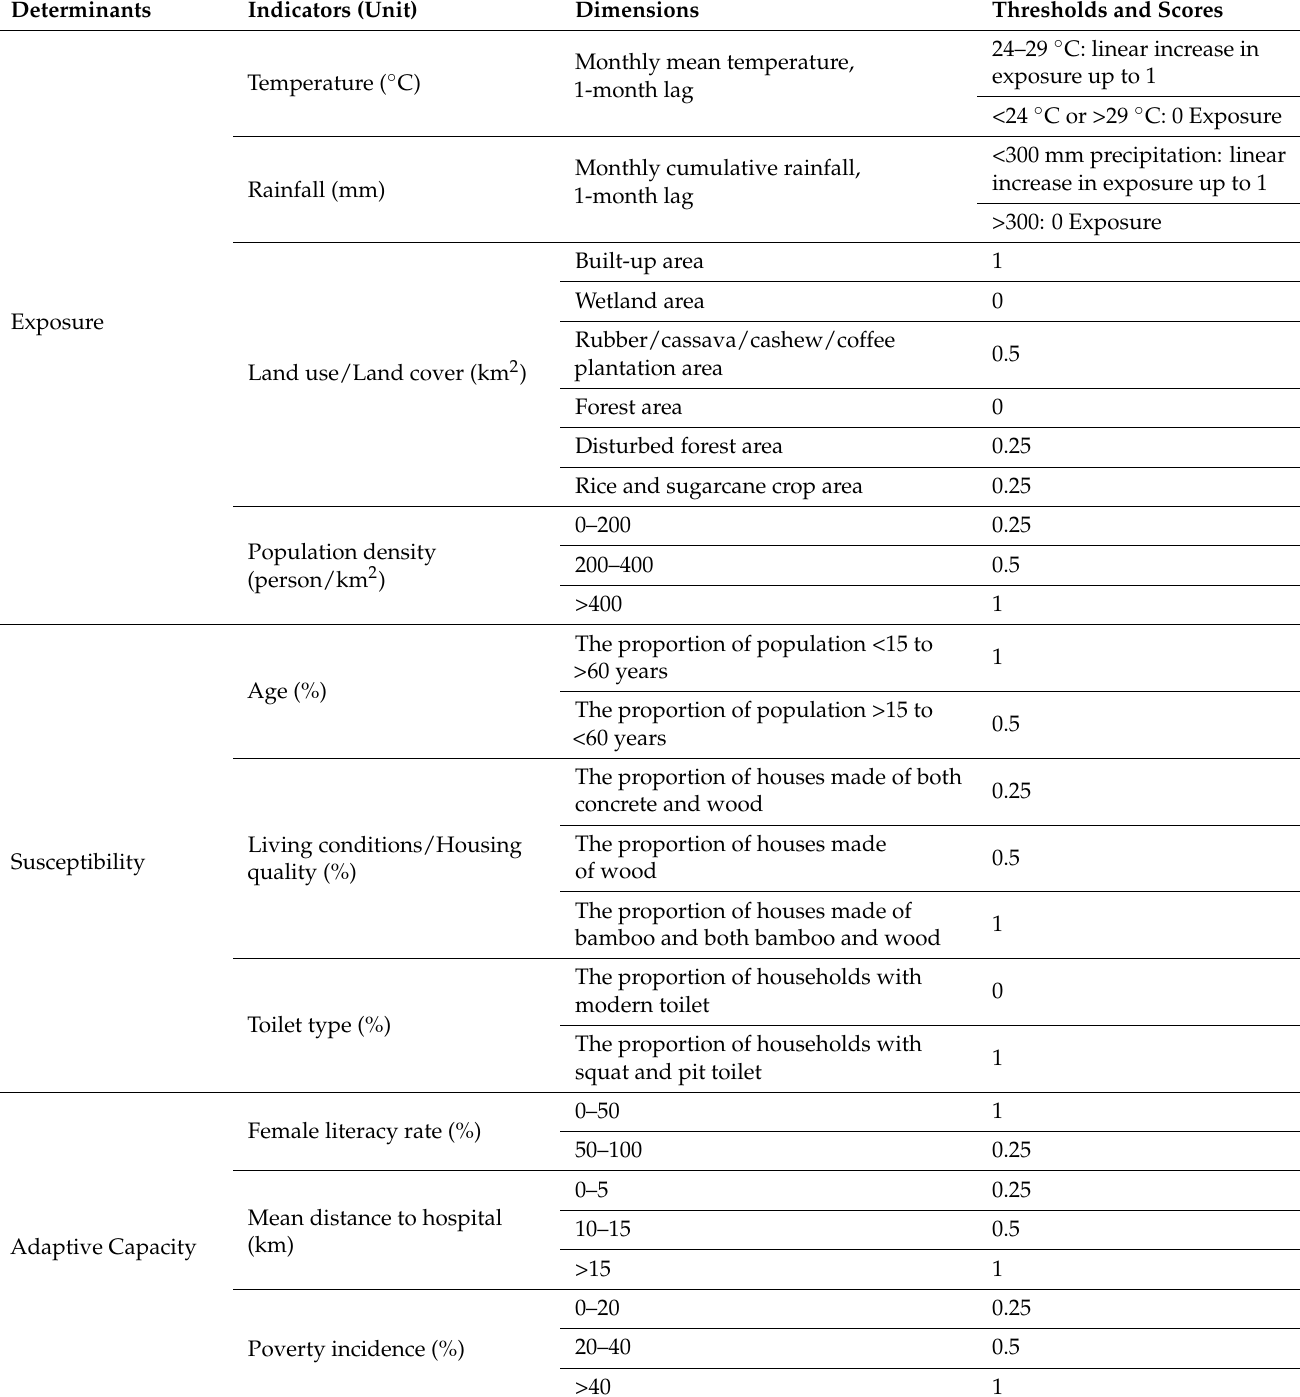
Table 2. Thresholds/Scores of indicators of determinants for Water Associated Disease Index [14] and Best-Worst Method. The dimensions of each indicator identify threshold values suitable for dengue transmission and given a score between 0 and 1 accordingly. A score of 1 indicates highest suitability for dengue transmission. Fractions of scores, e.g., 0.25 or 0.5, indicate lower transmission suitability. Zero indicates the least transmission suitability. Thresholds for rainfall and temperature were selected based on a retrospective analysis in study provinces and given a score of 1 for temperatures a suitable for dengue transmission and zero otherwise [43]. Scores for the indicators of each determinant were selected based on existing findings and from models of DENV transmission risk available in the literature